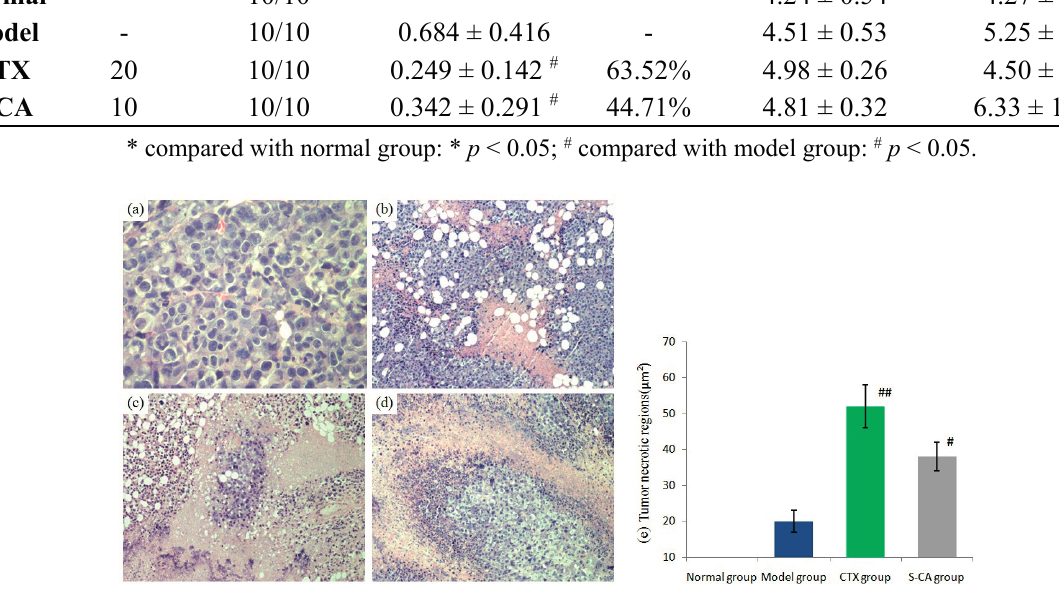
Figure 3. Histopathology of the mice bearing S180 xenografts after the treatment for 15 days. # compared with model group: # p < 0.05; ## compared with model group: ## p < 0.01. ( a ) Model group (400×). ( b ) Model group (100×). ( c ) CTX group (100×). ( d ) S-CA group (100×). ( e ) Tumor necrotic regions with HE staining of model and treatment groups of S180